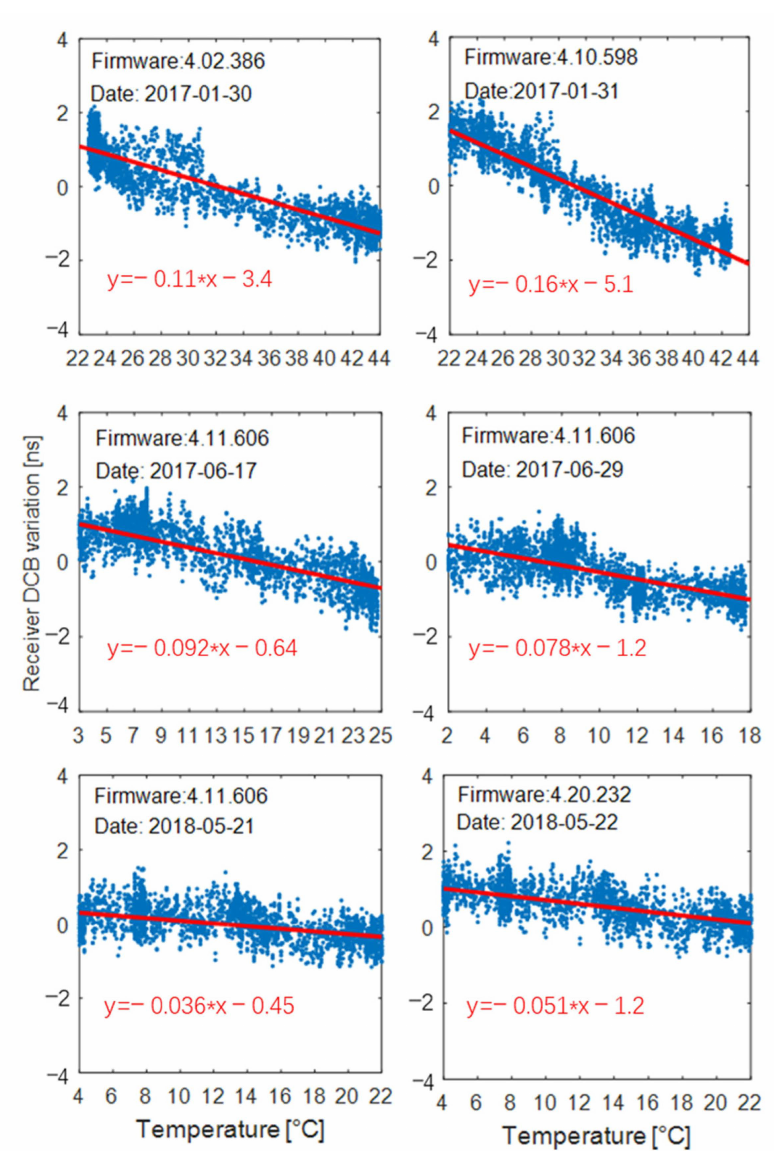
Figure 12. Receiver DCB variations (vertical axis) plotted as a function of the intraday temperature values (horizontal axis). The red line represents the results obtained by fitting a linear regression equation to the same dataset used in Figure